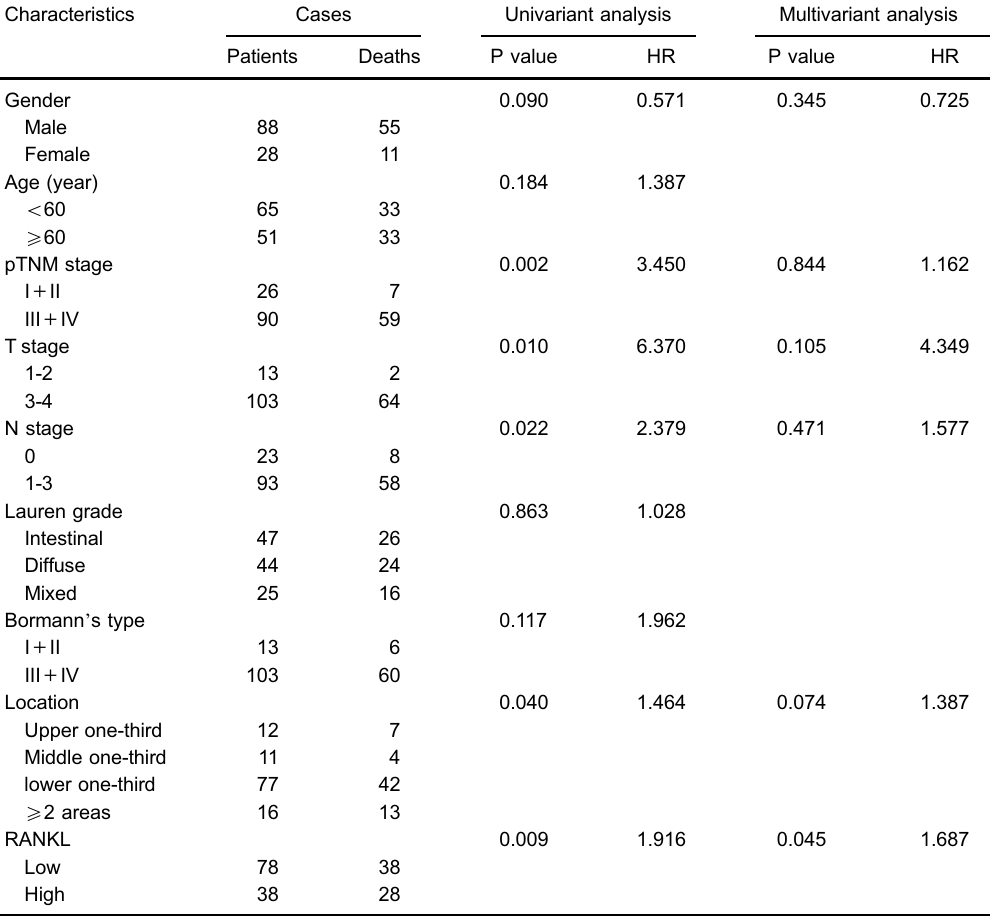
Table 3. Univariate and multivariate analyses of overall survival according to clinicopathological factors and RANKL expression.